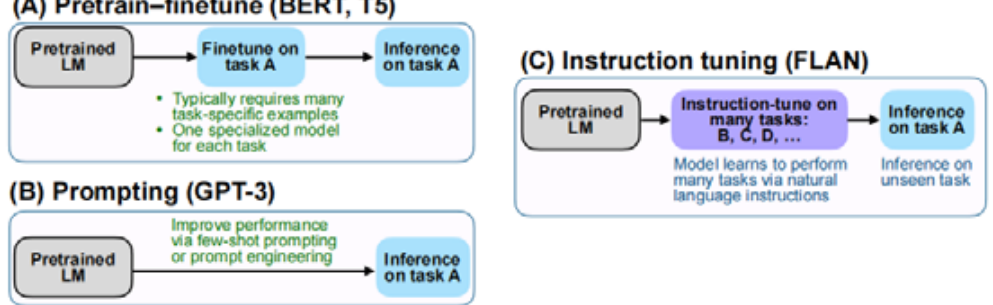
ChatGPT technical